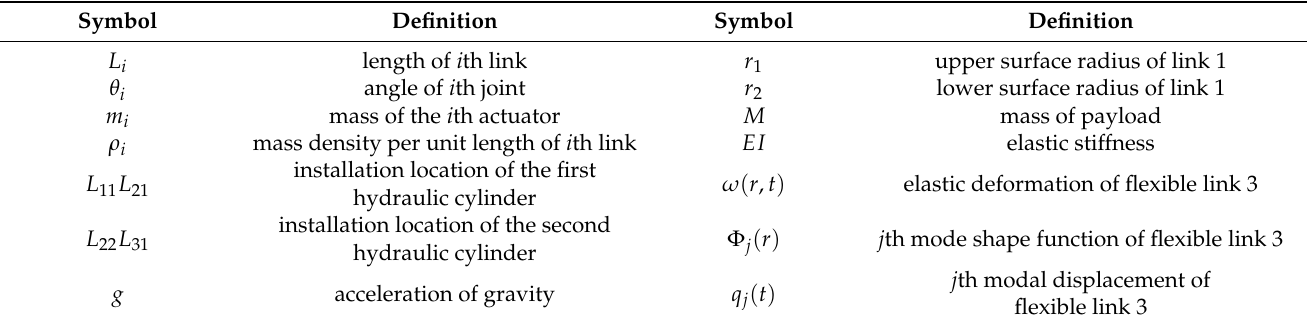
Table 1. Notation, frequently used symbols of mechanical subsystem. Symbol